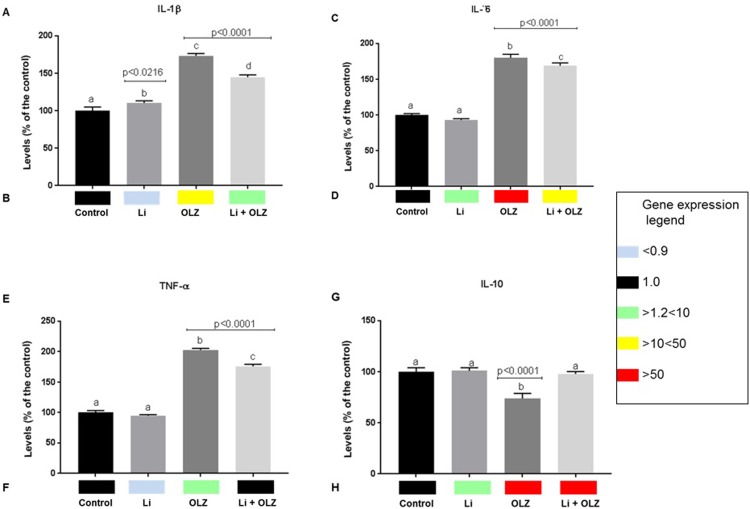
Modulation of protein and gene expression cytokines (IL-1β, IL-6, TNFα, IL-10) involved with inflammatory response of RAW macrophages exposed to OLZ (OLZ, 0.03 μg/mL) and Li (Li, and 0.7 mEq/L).Treatments were compared by one-way analysis of variance (ANOVA), followed by the Tukey post hoc test. The different letters (i.e., A, B, C, D) indicate statistical differences in each treatment at p < 0.05. Treatments with A letter were considered with values similar to C untreated-cells group. Gene expression of each cytokine in each treatment is represented by colored squares (black = gene expression similar to C-group; green square = gene overexpression ≥ 1.2 < 10 times than C-group; yellow square = gene overexpression ≥ 10 < 50 times than C-group; red square = gene overexpression ≥ 50 times than C-group. The beta-actin housekeeping was used as internal control to normalized gene expression analysis among treatments.